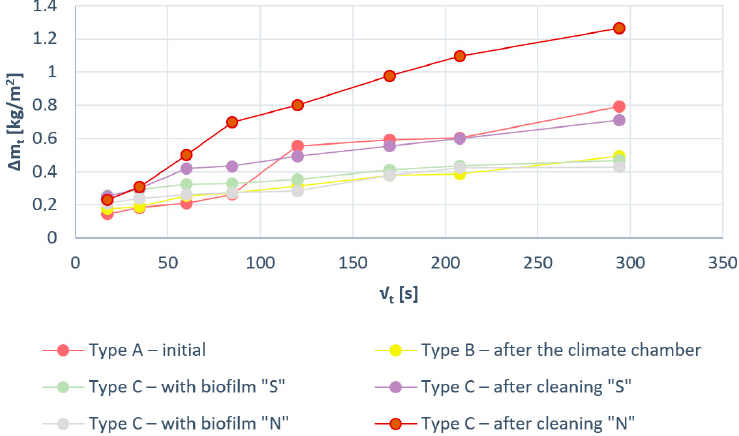
Figure 7. Graphs of ∆ m t /F as a function of the time element t 0.5 related to mineral-based plaster samples.